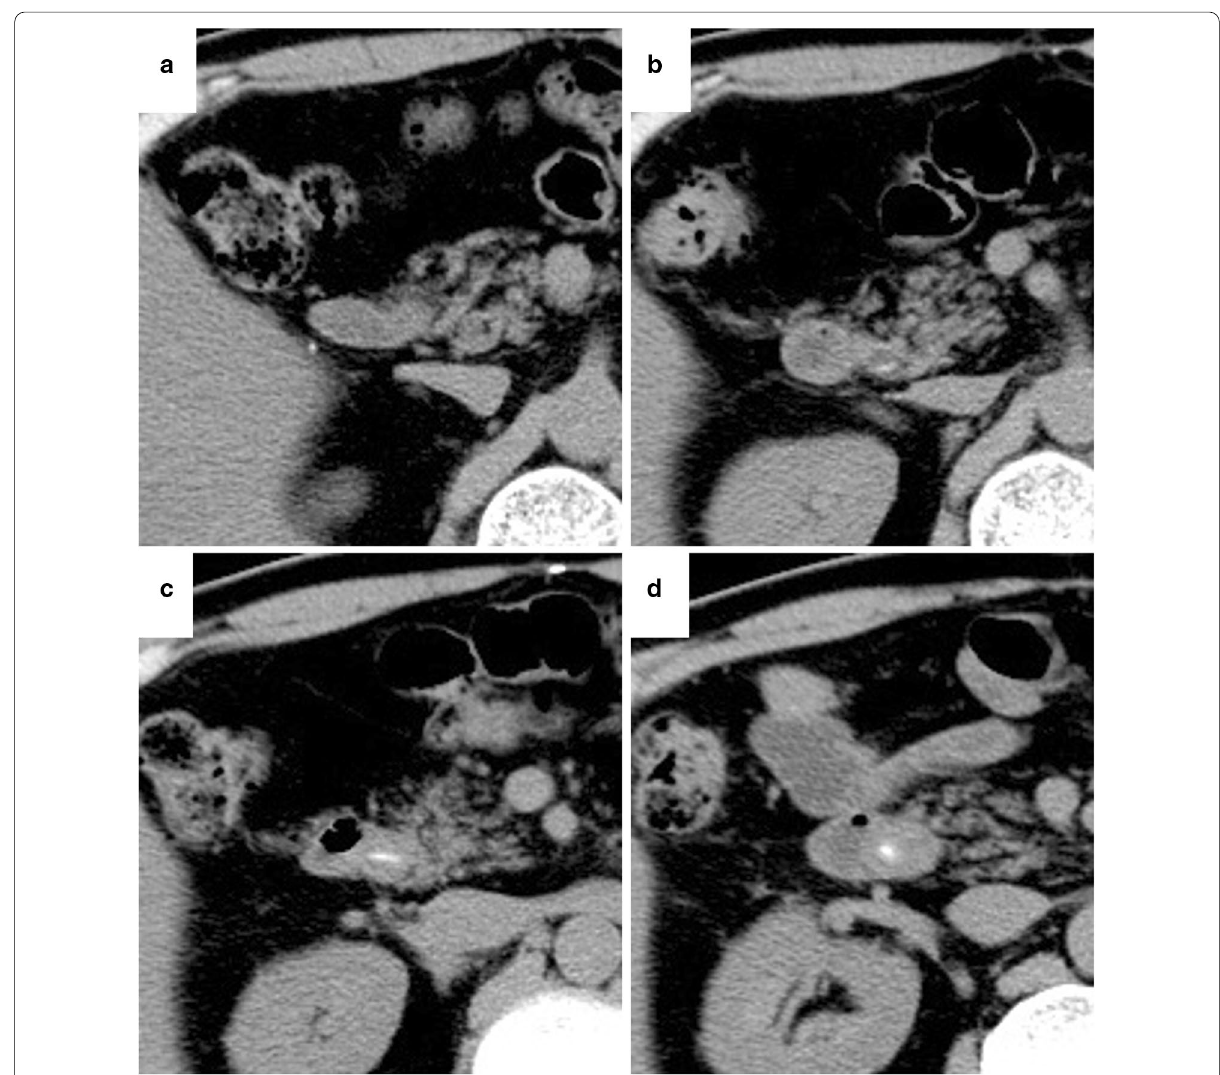
Fig. 1 The time series of the surveillance computed tomography (CT) after gastrectomy. In 2012, 7 years after the patient underwent distal gastrectomy with Roux-en-Y reconstruction for gastric cancer, the common bile duct (CBD) stone was not detected ( a ). In 2015, at the past CT scan review, a spotted high-density area was recognized ( b ). The stone formation was also recognized in 2016, although the patient had no symptoms ( c ). CBD dilatation with stone formation causing obstructive jaundice was detected in 2017 ( d